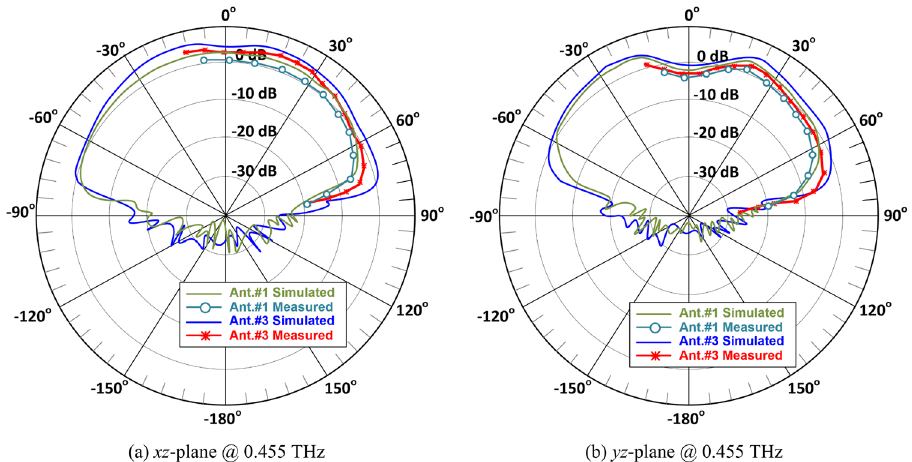
Figure 11. Simulated and measured radiation patterns of the proposed AoC in the orthogonal planes at 0.455 GHz.